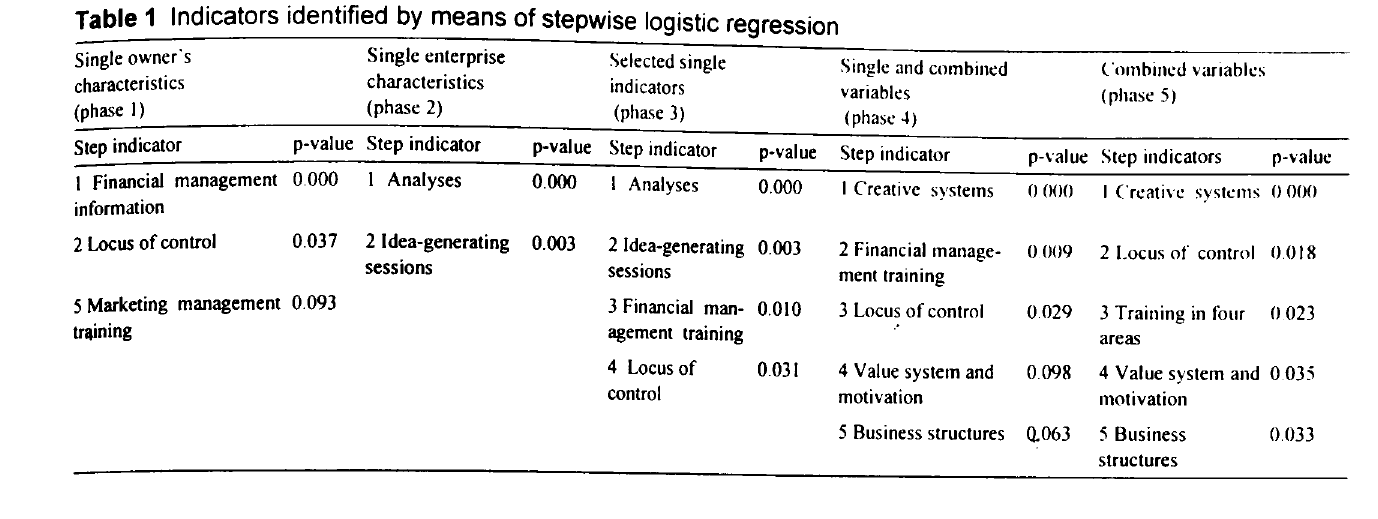
Table 1 Indicators identified by means of stepwise logistic